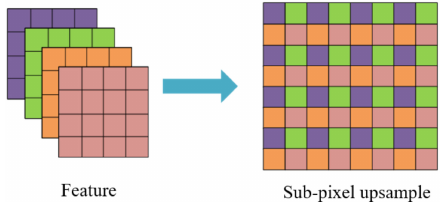
Figure 2. Sub-pixel convolution